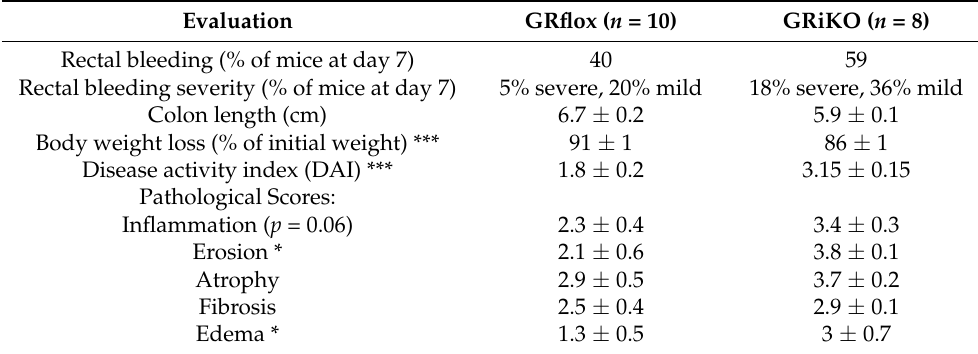
Table 2. Clinical and histopathological scores from DSS mice models.